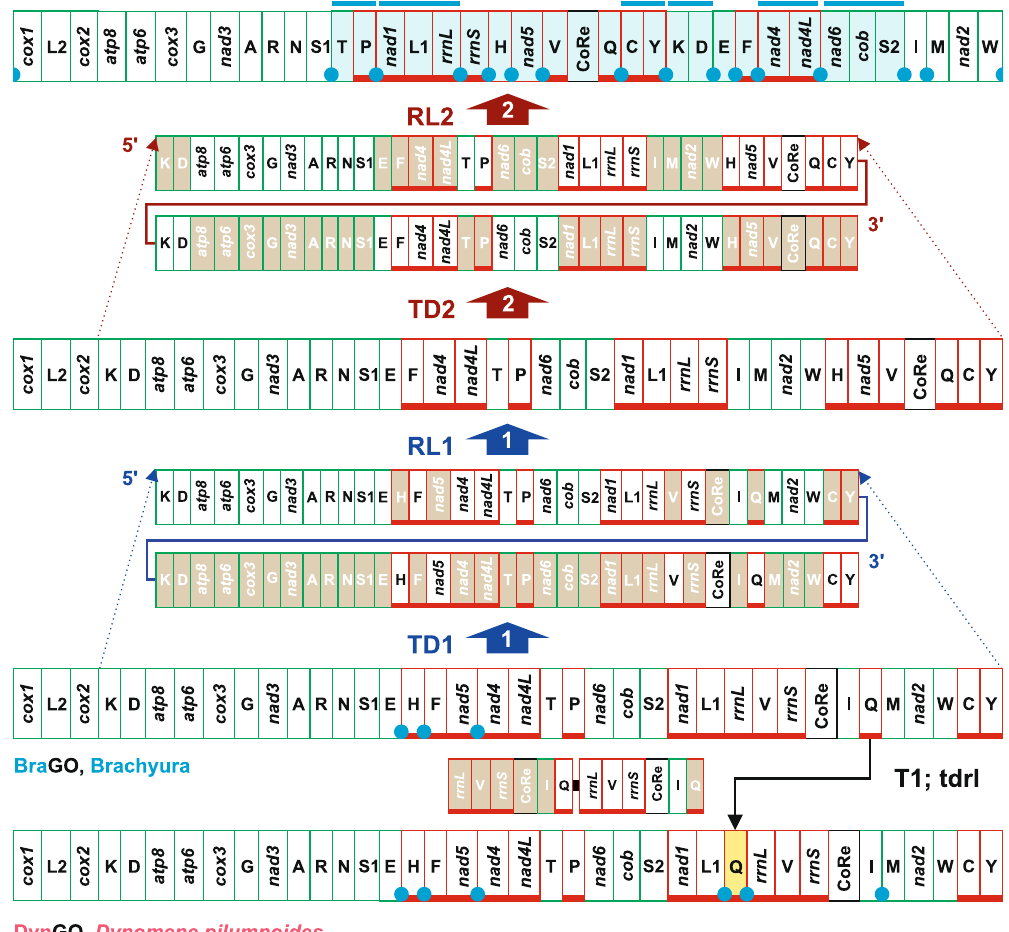
crab GOs (Fig. 4). Notably, the transformational pathway going from BraGO to MaVaGO, computed as the most parsimonious scenario by CREx, implies only two TDRL events, without an early transposition of trnQ , an event hypothesised in the TreeREx reconstruction (see above). The CREx reconstruction further corroborates the man- ual assignment of BraGO to nodes a-c of Fig. 4. Intergenic spacers, occurring in positions involved in TDLRs, and possible remnants of genes support the MaVaGO scenario (Fig. 8, Supplementary Fig. S8).